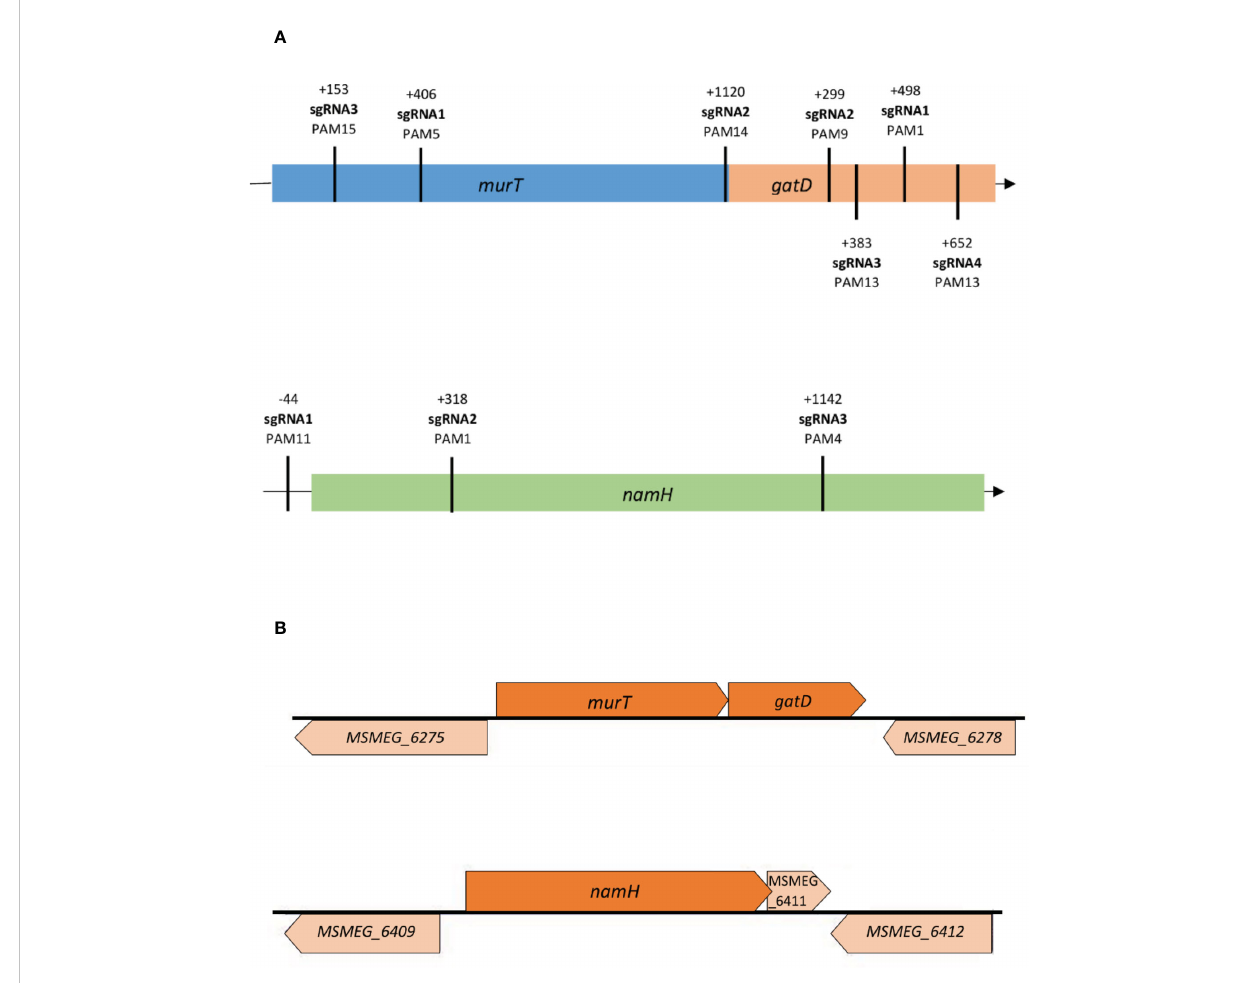
FIGURE 1 (A) Distribution of sgRNA targeting sequences along the murT / gatD operon and the namH gene in M. smegmatis . Different sites were targeted along the genes to assess the differential repression ef fi ciency of CRISPRi; (B) The gene local context (illustration based on data from the Biocyc database) of the target genes murT , gatD and namH in M. smegmatis needs to be considered due to possible downstream/upstream polar effects. The murT and gatD genes are co-transcribed under regulation of a single promoter. The MSMEG_6275 precedes the murT gene but is transcribed in the opposite direction while the MSMEG_6278 gene occurs after the gatD gene but is also transcribed in the opposite direction. A single promoter guides the conjoint transcription of the namH and MSMEG_6411 genes by RNA polymerase. The MSMEG_6409 precedes the namH gene but is transcribed in the opposite direction while the MSMEG_6412 gene occurs after the MSMEG_6411 gene but is also transcribed in the opposite